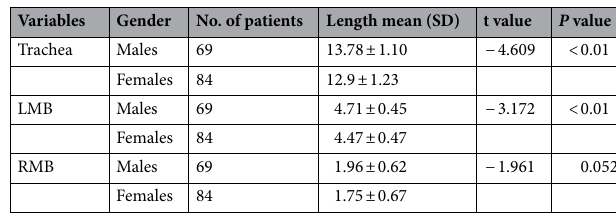
Table 2. Lengths of trachea and bronchus in males and